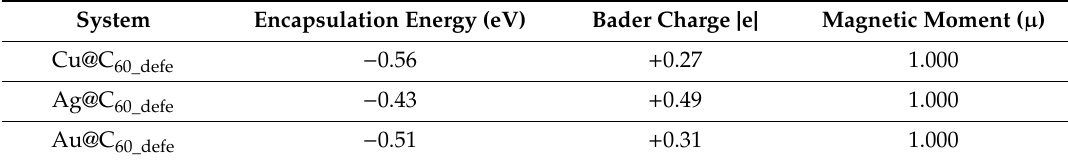
Figure 8. Relaxed structures and charge density plots of Cu ( a ), Ag ( b ) and Au ( c ) encapsulated within a defective C 60 molecule. Table 5. Encapsulation energies, Bader charge on the metal atoms and magnetic moments of the endohedral composites formed between the defective C 60 molecule and